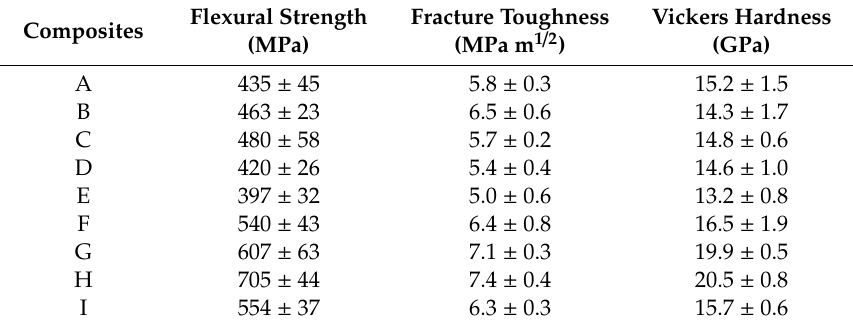
Table 2. Mechanical properties of composites.